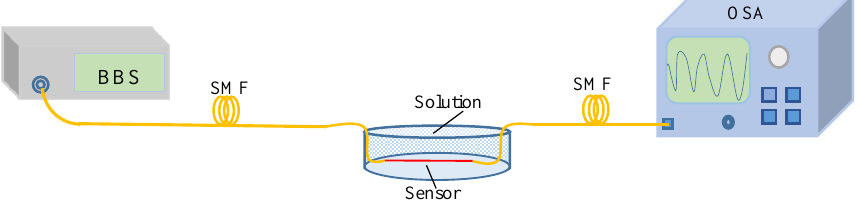
Figure 7. Solution RI sensing experimental setup.